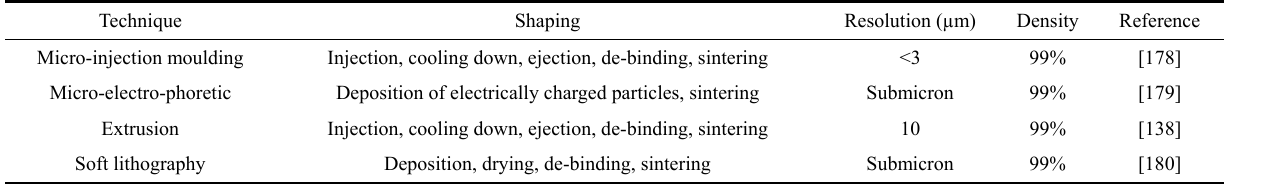
Fig. 24 Ceramic micro holes and micro gears fabricated using soft lithography with different particle sizes. Reproduced with permission from Ref. [171], © Elsevier Ltd. 2015, and Ref. [172], © WILEY-VCH Verlag GmbH 2000. Table 3 Summary of patterning techniques used for MEMS